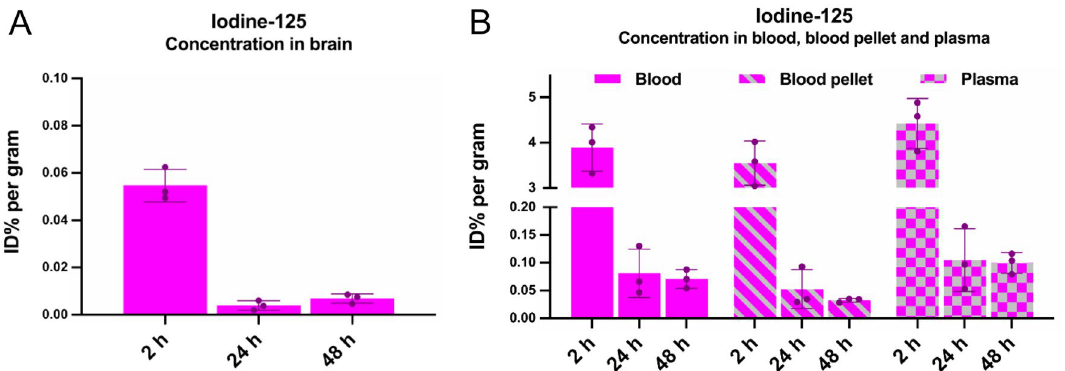
Figure 11. Brain penetrance and blood distribution of iodine-125. The brain penetrance and blood distribution of 125 I was investigated ex-vivo by measuring the activity 2 h (n = 3), 24 h (n = 3) and 48 h (n = 3) post intravenous injection in WT-mice, presented as of %ID/g. ( A ) Ex-vivo concentration of 125 I in brain. ( B ) Blood distribution of 125 I. Results are presented as mean ±